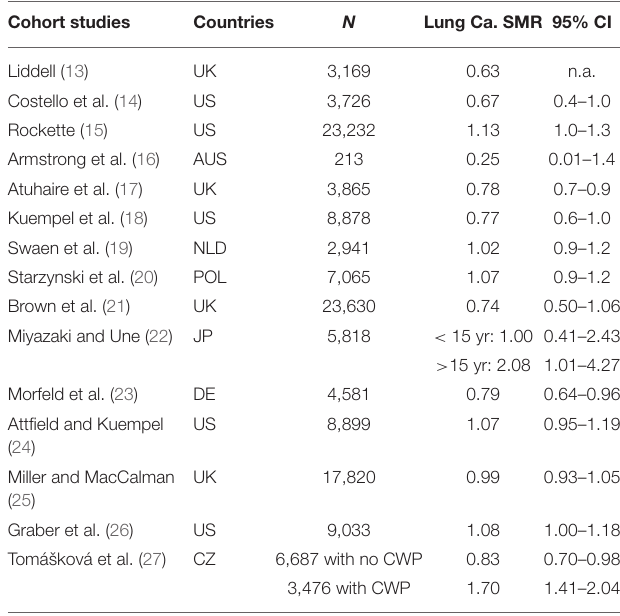
TABLE 7 | Summary of 15 cohort studies of coal miners with lung cancer standardized mortality ratios (SMR) and 95% confidence intervals